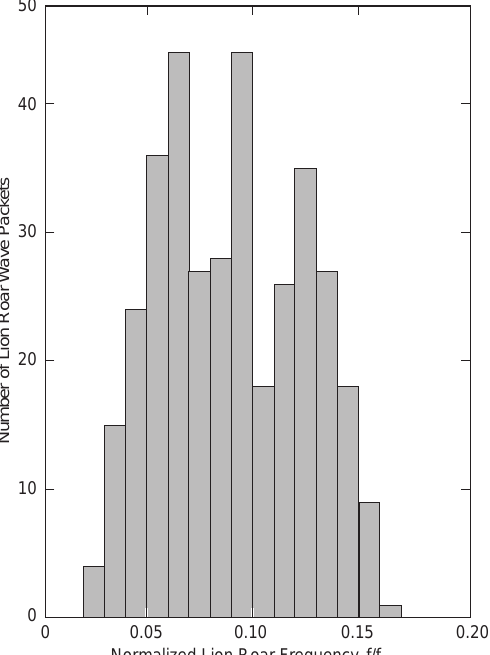
Fig. 4. Occurrence distribution of normalized lion roar frequencies